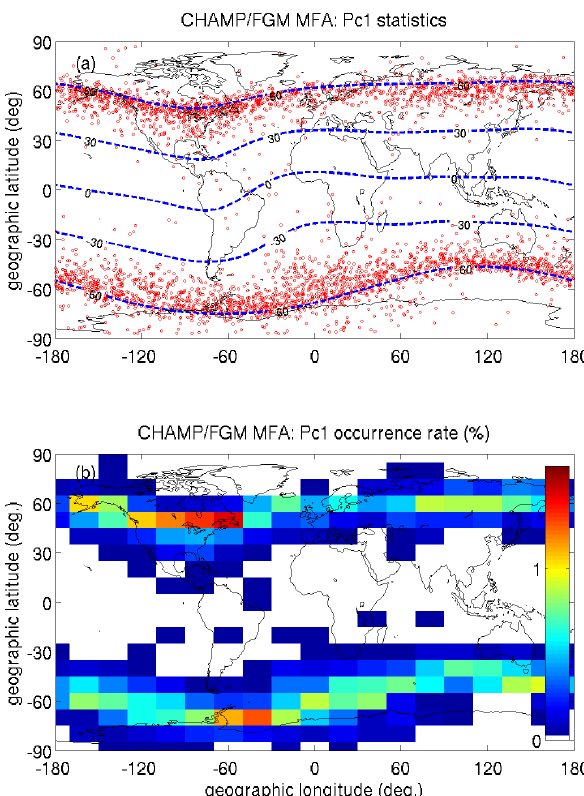
Fig. 8. Global distribution of the Pc1 events: (a) scatter plot of indi- vidual events, and (b) occurrence rate normalized by the number of CHAMP passes over that bin. The blue dashed curves in (a) repre- sent MLAT contours at 30 ◦ intervals.